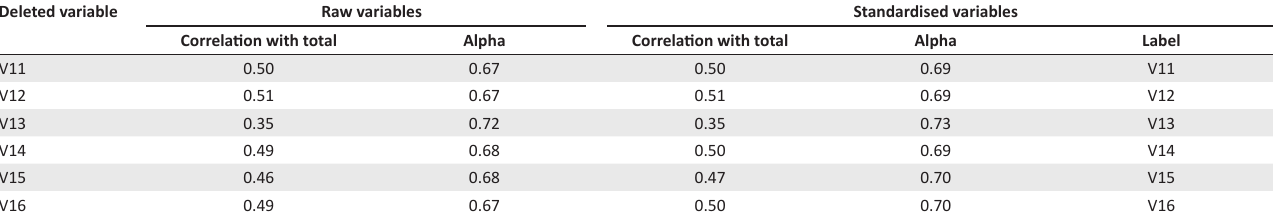
TABLE 3: PROC CORR results. Self-efficacy 6 Variables: V11, V12, V13, V14, V15, V16. Cronbach coefficient Alpha with deleted Variable (where applicable).